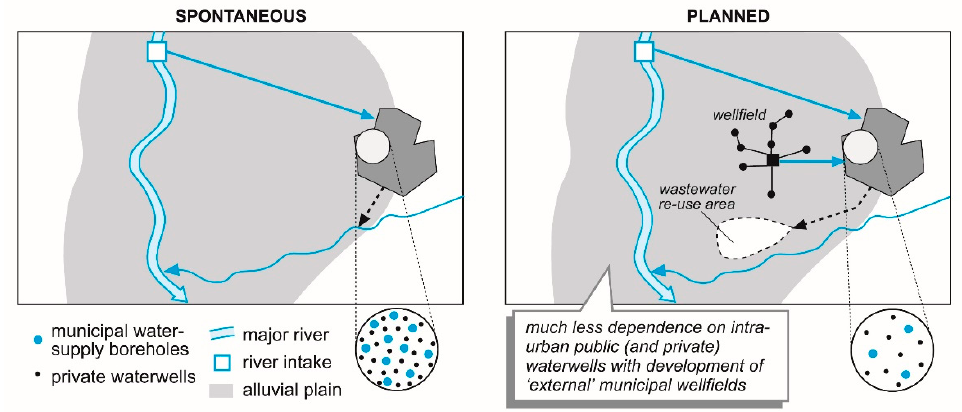
Figure 1. Planned and spontaneous conjunctive use for urban water-supply.